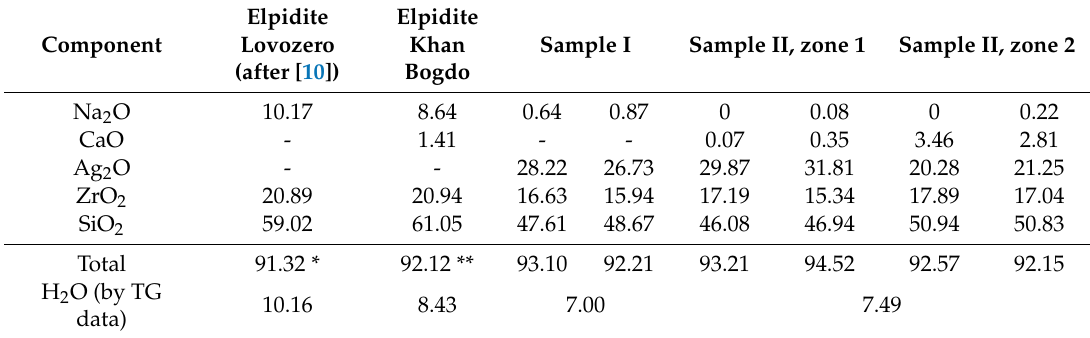
Table 3. Chemical composition (wt. %) of initial and Ag-exchanged elpidite samples.